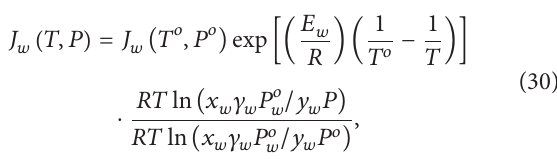
Figure 5: Effect of feed water concentration (wt%) on separation factor of water-organic pervaporation system.